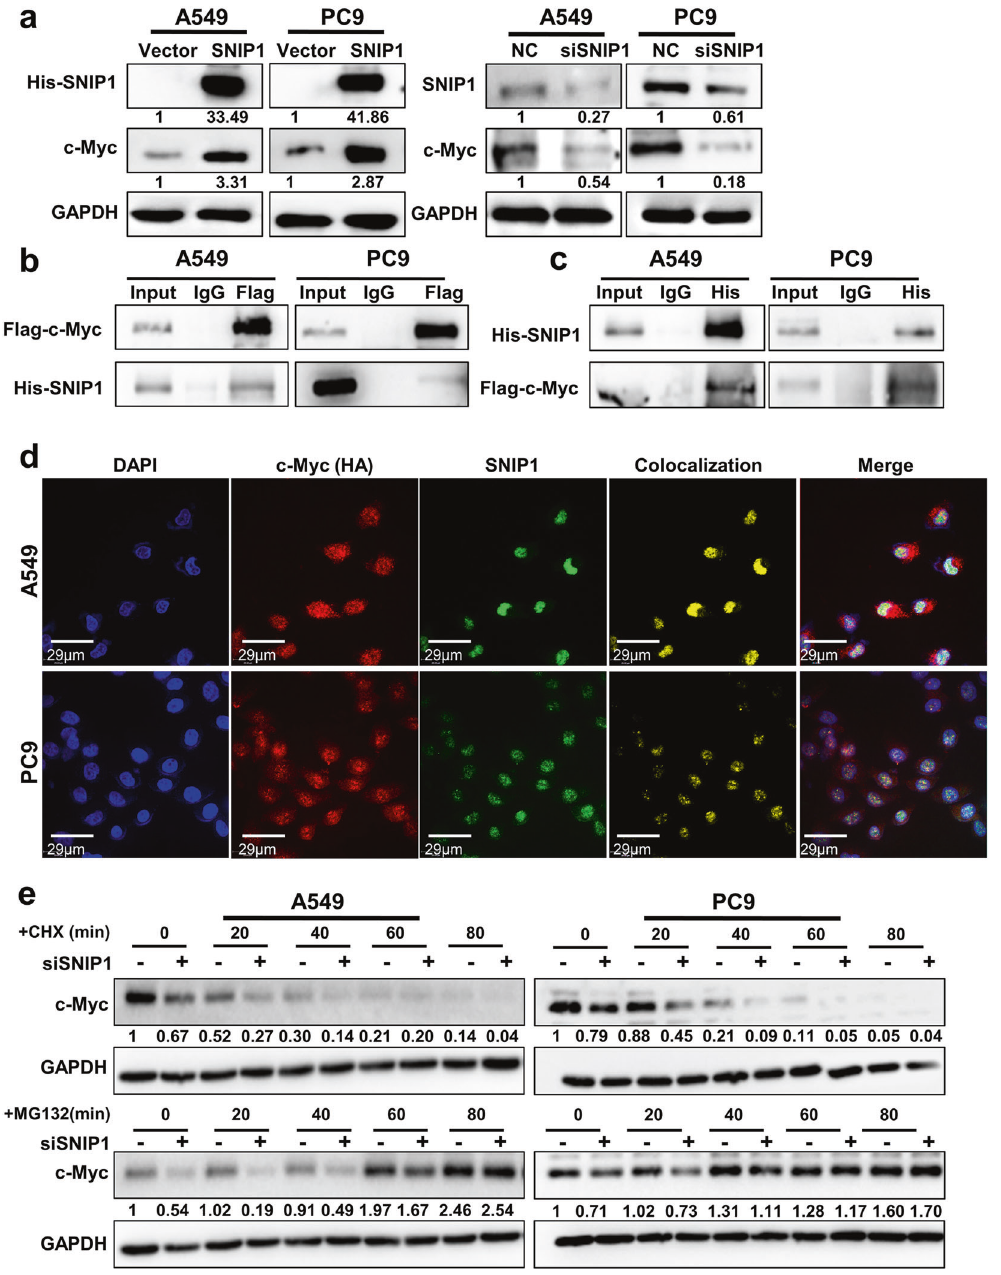
Fig. 5 SNIP1 inhibits c-Myc protein degradation. a The c-Myc expression in A549 and PC9 cells after knockdown or overexpression of SNIP1 by western blotting. b The interaction between c-Myc and SNIP1 using anti-Flag (c-Myc) antibody in A549 and PC9 cells co-transfected with the Flag-c-Myc and His-SNIP1 vectors was examined by immunoprecipitation. c The interaction between SNIP1 and c-Myc proteins using anti-His (SNIP1) antibody in A549 and PC9 cells co-transfected with the His-SNIP1 and Flag-c-Myc vectors by IP experiment. d Immuno fl uorescence experiments performed using anti-HA (c-Myc) and anti-SNIP1 antibodies in A549 and PC9 cells showed that c-Myc and SNIP1 were colocalized. DAPI-stained nucleus: blue; anti-HA (c-Myc): red; anti-SNIP1: green; colocalization of c-Myc and SNIP1: yellow; the merged image represents the overlap of DAPI, c-Myc, and SNIP1 (Scale bar: 29 μ m). e After knockdown of SNIP1 via transient transfection, A549 and PC9 cells were treated with 50 μ g/ml CHX or 20 μ M MG132 for 0 – 80 min, followed by detection of c-Myc protein levels using western blotting method. The results showed that only MG132 abolished the downregulation of c-Myc caused by